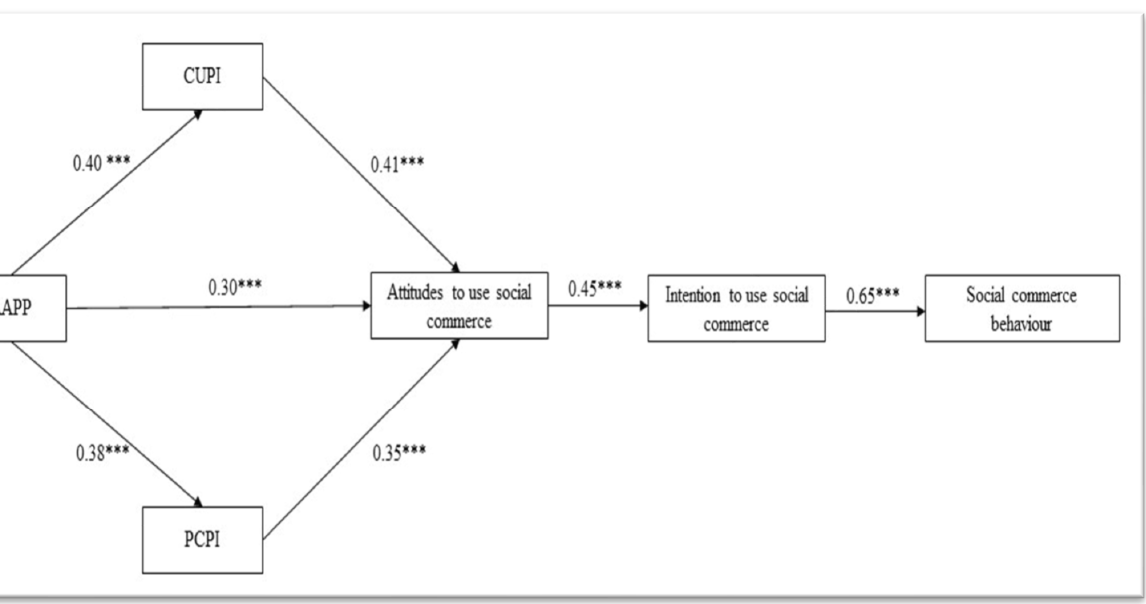
Table 6. Goodness-of-fit indices.